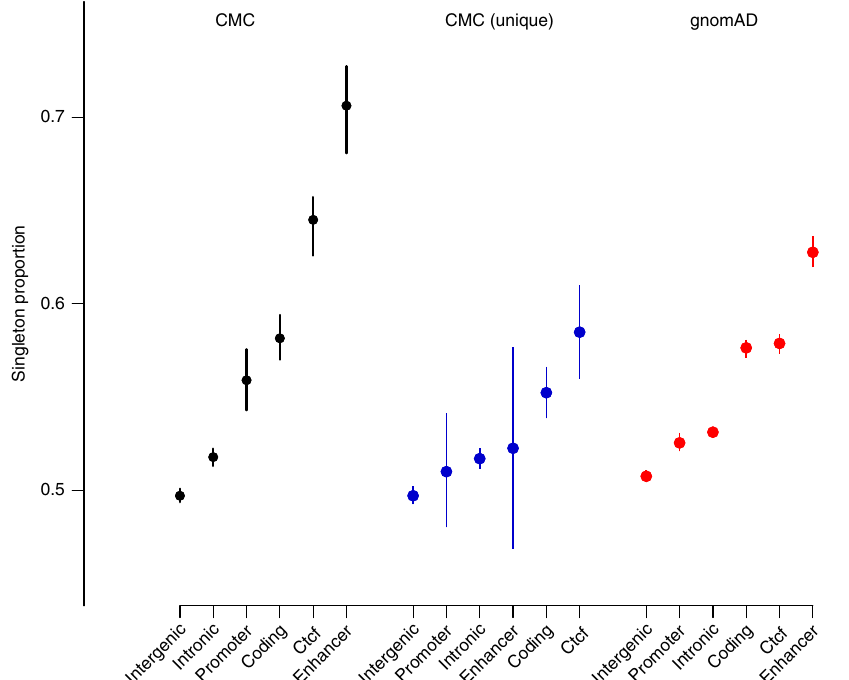
Fig. 2 Genic and regulatory SVs occur at signi fi cantly lower frequencies. Proportion of variants that are seen only a single time with bootstrapped 95% con fi dence interval in the sample strati fi ed by overlap with any annotation, allowing for multiple (CMC), only a single annotation (CMC unique) and any annotation in gnomAD